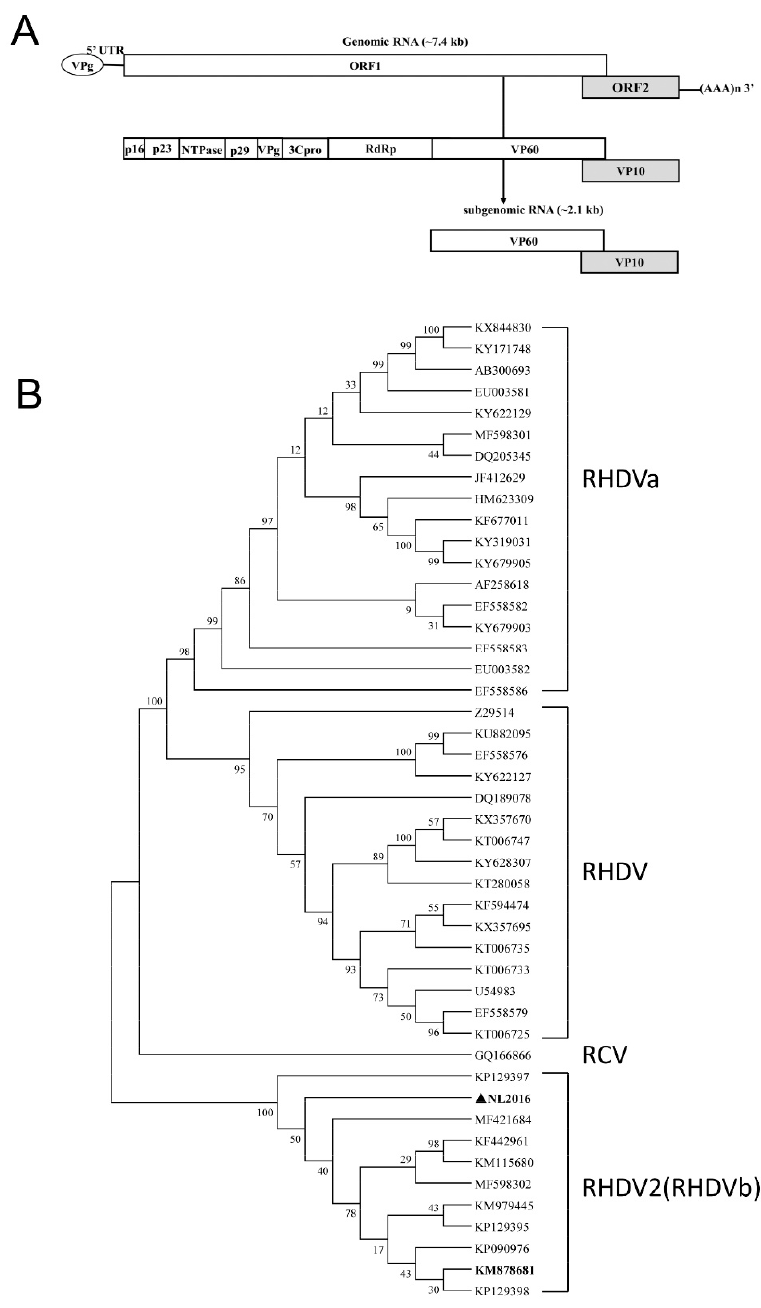
Figure 1. Genome organization of strain RHDV2-NL2016 and phylogenetic analysis. ( A ) Genome organization of RHDV2. The RHDV2 genome is a 3’polyadenylated single-stranded positive-sense RNA of ~7.4 kb encoding 2 open reading frames (ORFs). A subgenomic mRNA of ~2.1 kb is formed during viral RNA replication. A viral genome-linked protein (VPg) is covalently attached to the 5’ untranslated region (5’UTR). ORF1 encodes a polyprotein that is proteolytically cleaved to form the non-structural proteins p16, p23, NTPase, p29, VPg, the viral protease 3Cpro, the RNA-dependent RNA polymerase (RdRp) and the major capsid protein VP60. ORF2 encodes the minor structural protein VP10. ( B ) Phylogenetic neighbour-joining tree constructed based on the VP60 gene of RHDV2-NL2016 and multiple reference sequences (Table 2).